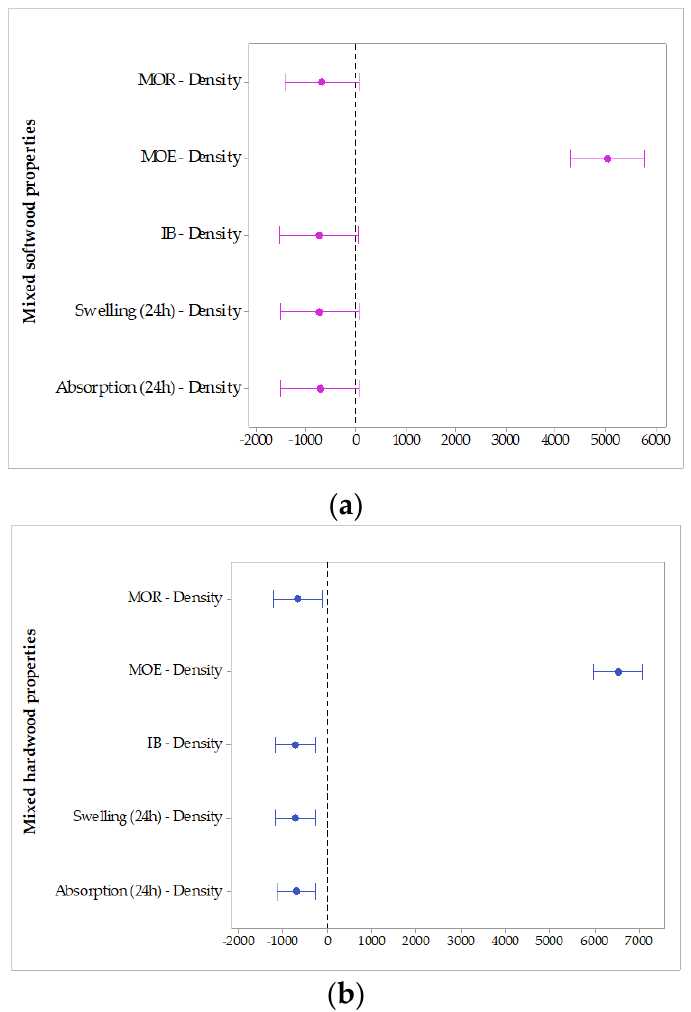
Figure 9. Comparative analysis of OSB panel properties from mixed species of softwood ( a ) and hardwood ( b ) .